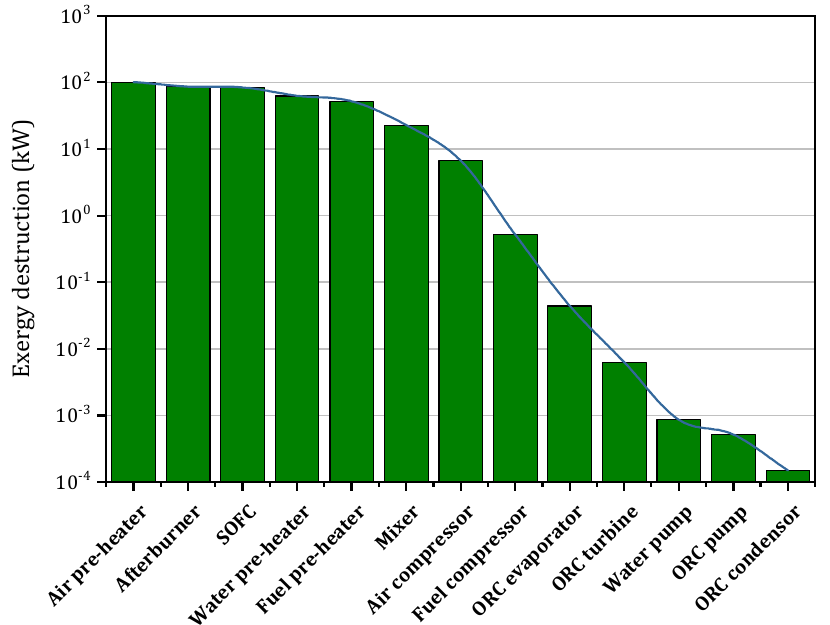
Figure 2. Exergy destruction of the utilized components in the integrated design.